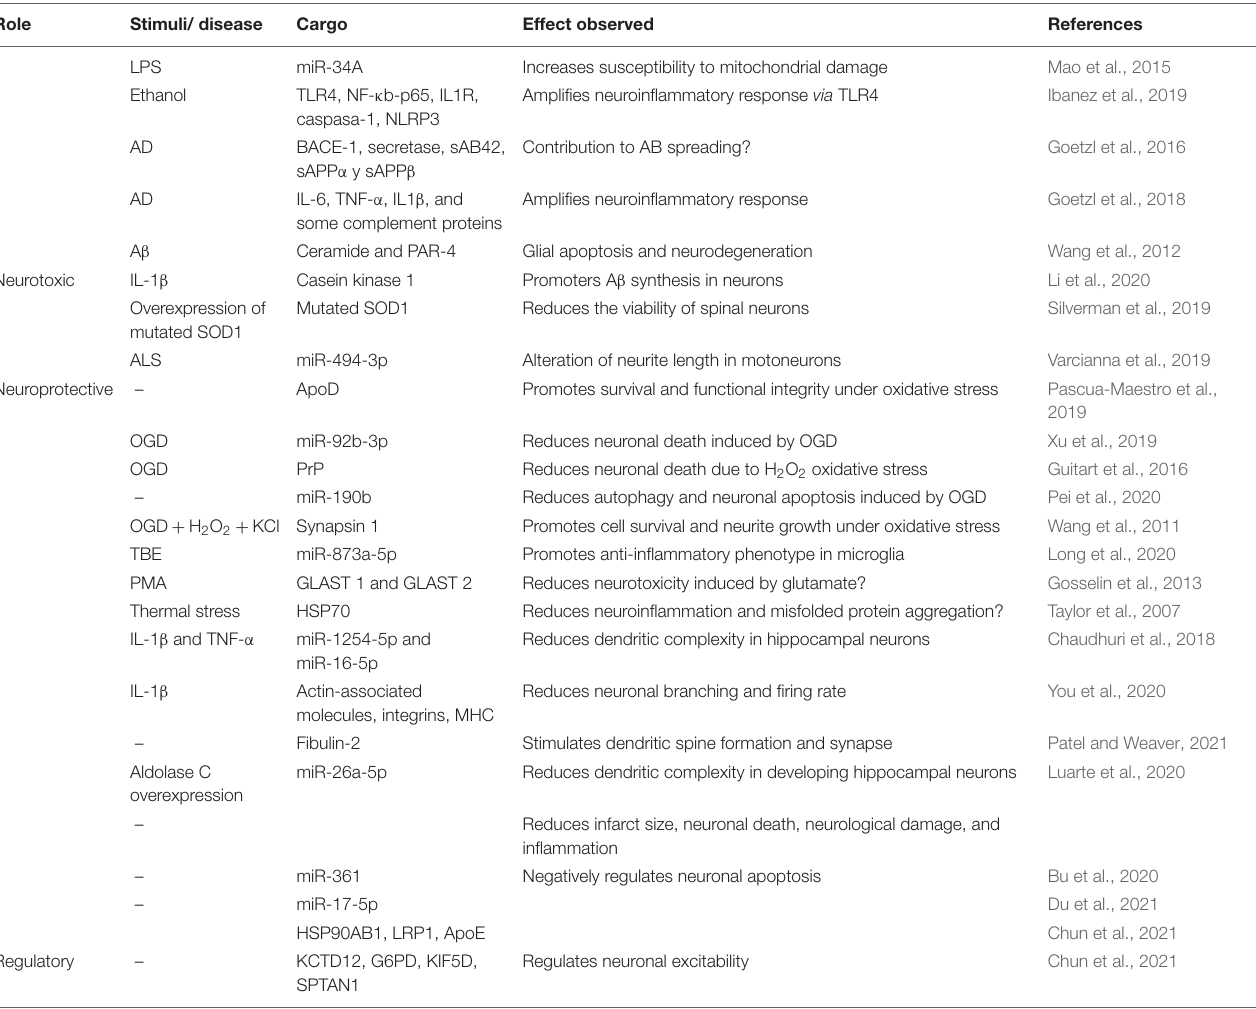
TABLE 1 | Summary of neuroprotective and neurotoxic effects of astrocytes-derived exosomes with identified